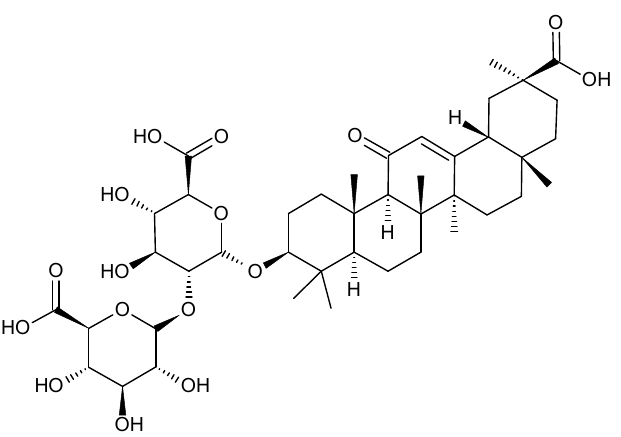
Figure 1. The chemical structure of glycyrrhizin